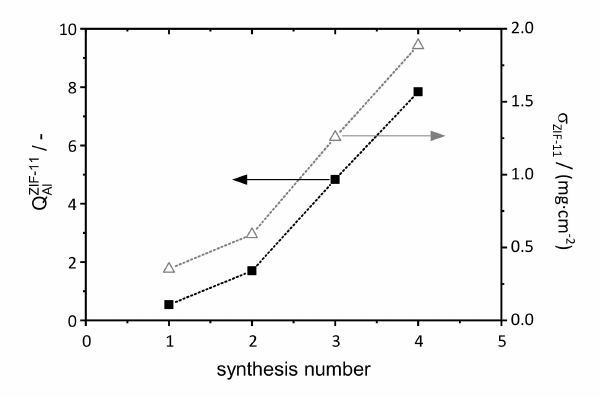
Figure 8. Crystallinity and ZIF-11 loading as a function of synthesis number during multiple in situ crystallization on a porous stainless-steel support (Mott Corporation).